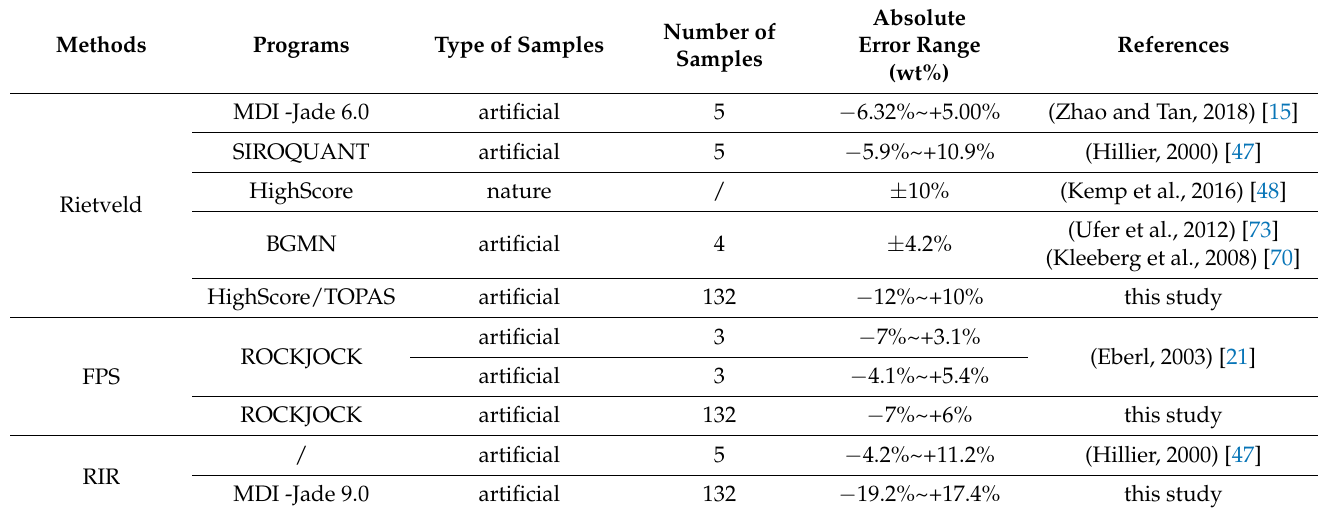
Table 3. A summary of analytical accuracies of various quantitative methods for phyllosilicate clay